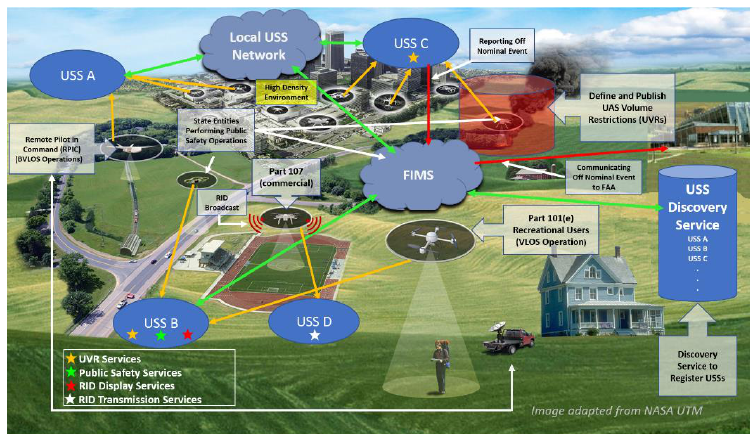
Figure 5. FAA UTM Pilot Program (UPP) conceptual overview [17]. Table 1. UAF / ACUASI participation in UTM TCL1-3